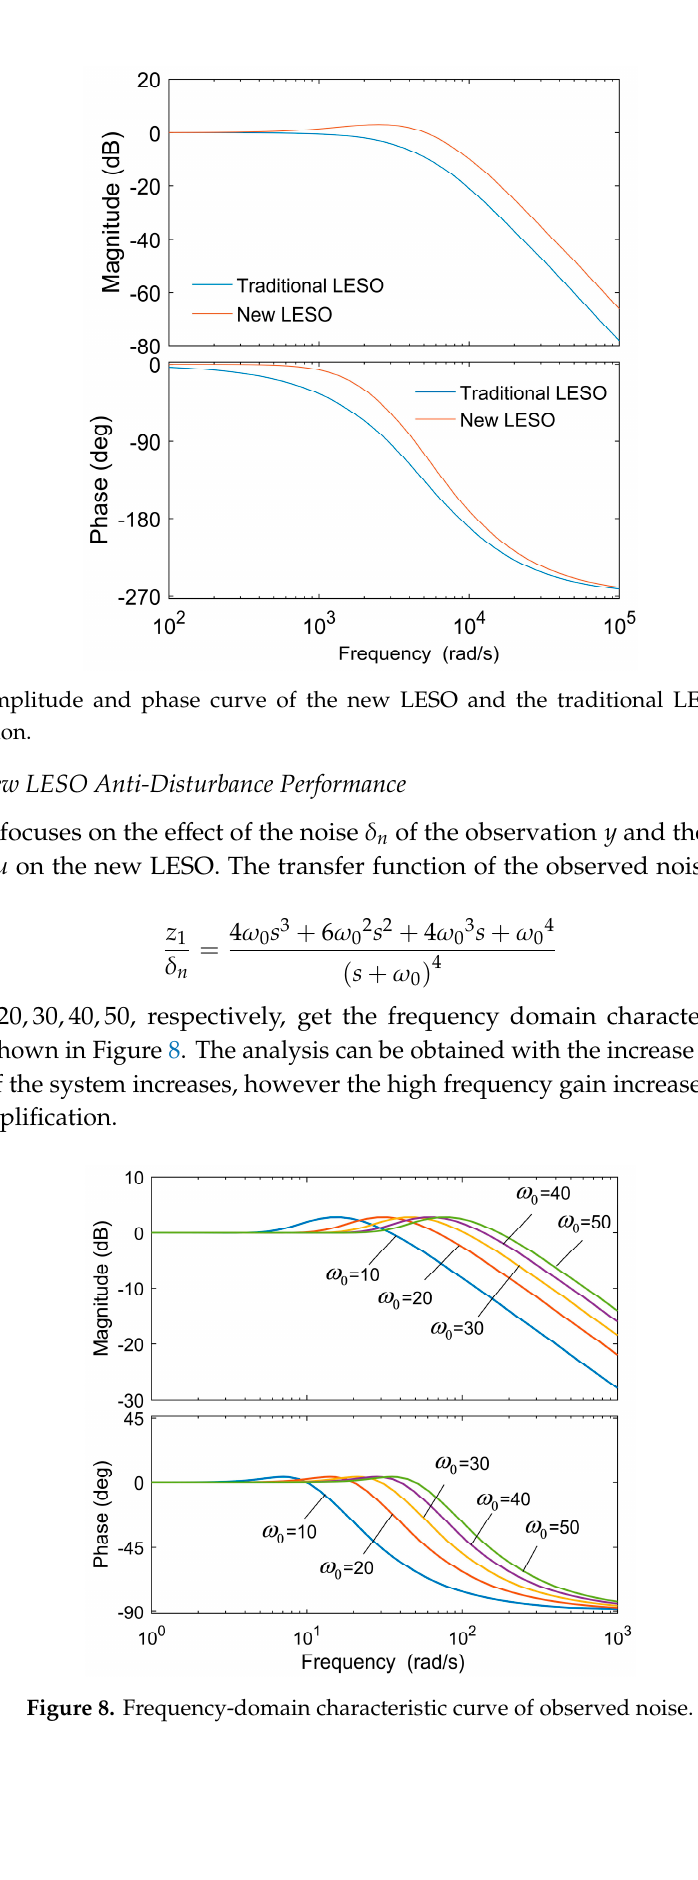
Figure 9. Frequency-domain characteristic curve of input disturbance. It can be seen from the above analysis that the new LESO with total perturbation differential structure is still effective and robust when subjected to observation disturbance and input disturbance.